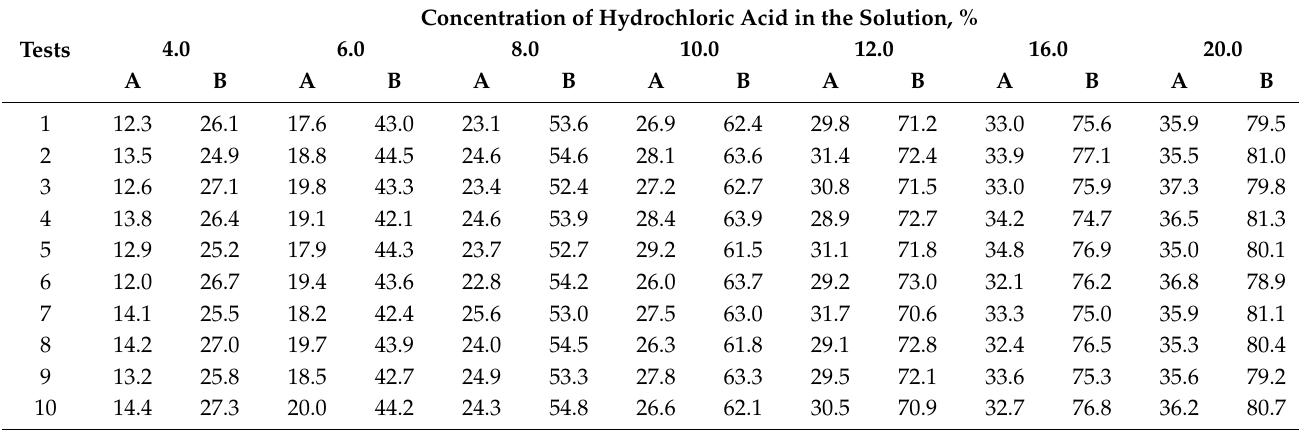
Table 5. Iron extraction (%) without mechanical activation (A) and with mechanical activation (B).